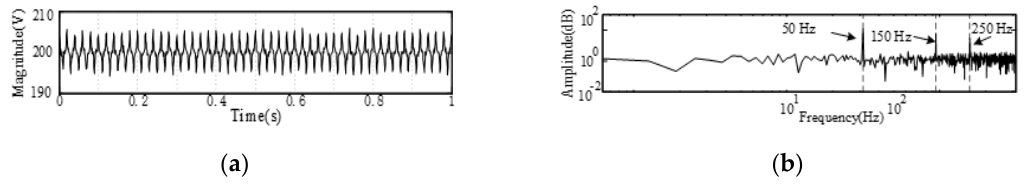
Figure 11. Performance of input signals under noise condition: ( a ) amplitude, ( b ) spectrum.